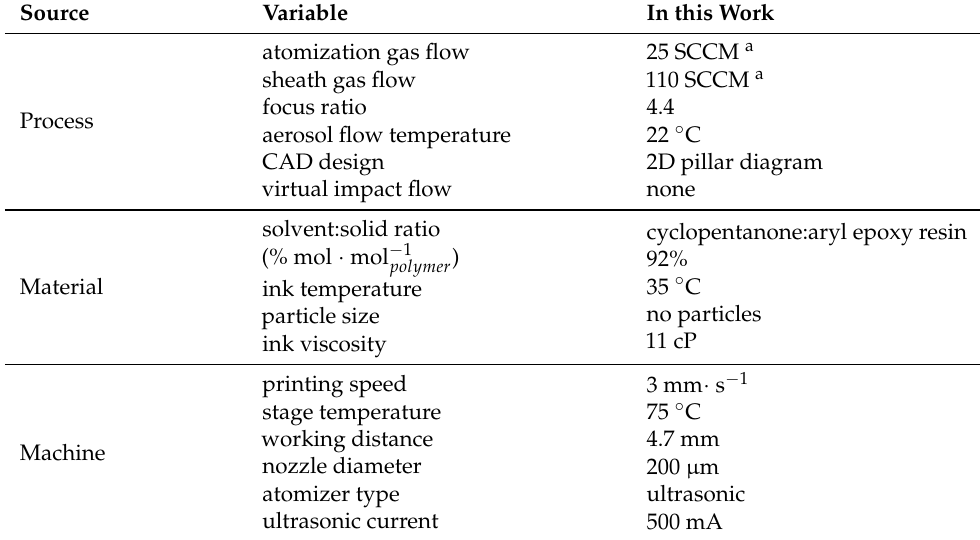
Figure 2. Aerosol jet printing. ( a ) AJ 5X equipment (Optomec—Albuquerque, US) with a 5-axis motion system. ( b ) Ultrasonic atomizer chamber. ( c ) Aerosolization process. ( d ) Printing nozzle. ( e ) Representation of an aerolized material and sheath gas inside the nozzle path. ( f ) Focused aerosolized material. Table 1. Principal AJP